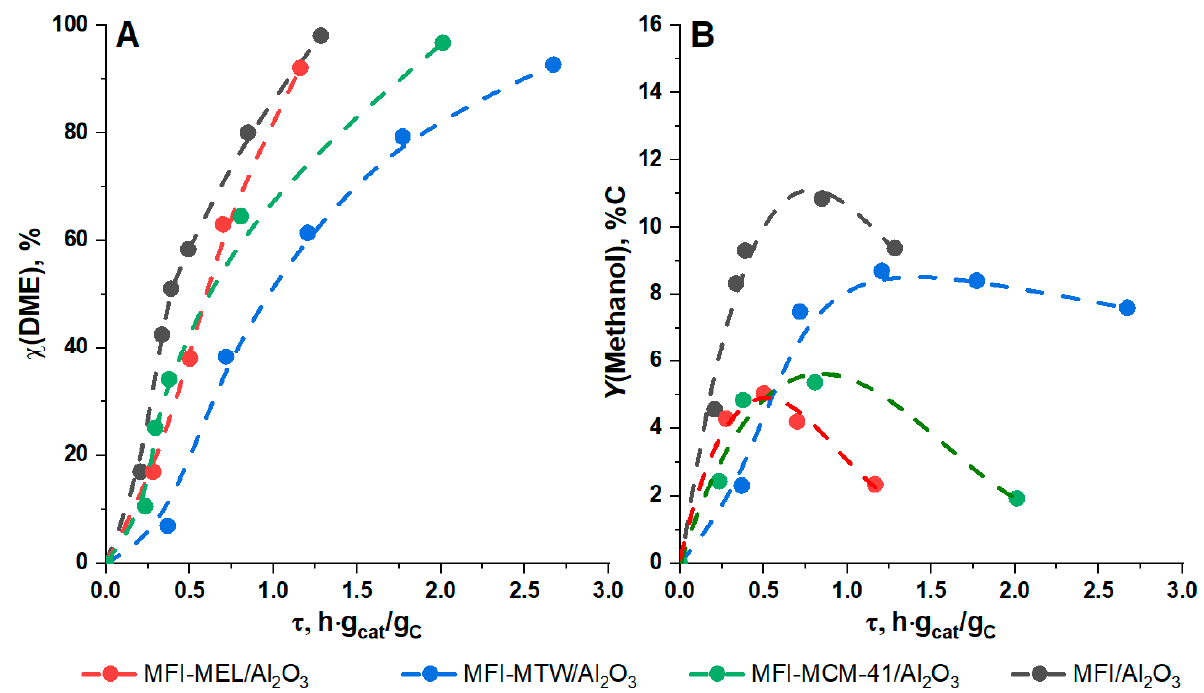
Figure 3. DME conversion ( A ) and methanol yield ( B ) as functions of specified contact time. p = 1 atm, T = 340 °C.